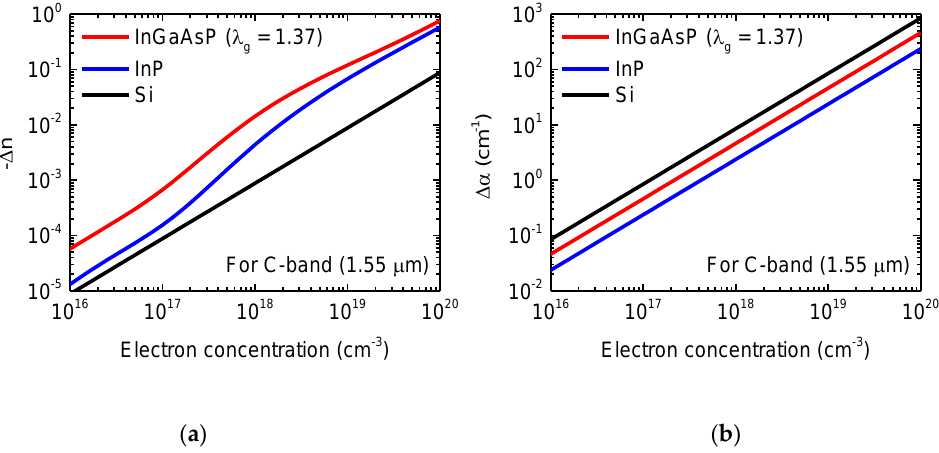
Figure 4. Numerical analysis of an InGaAsP/Si hybrid MOS optical modulator ( a ) Electron-induced refractive index changes (Δ n ) of InGaAsP, InP and Si, ( b ) Electron-induced absorption changes (Δα) of InGaAsP, InP and Si [61].